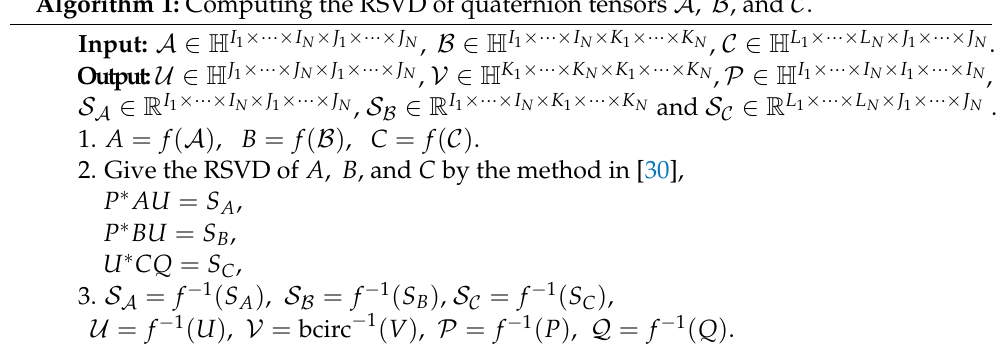
Algorithm 1: Computing the RSVD of quaternion tensors A , B , and C